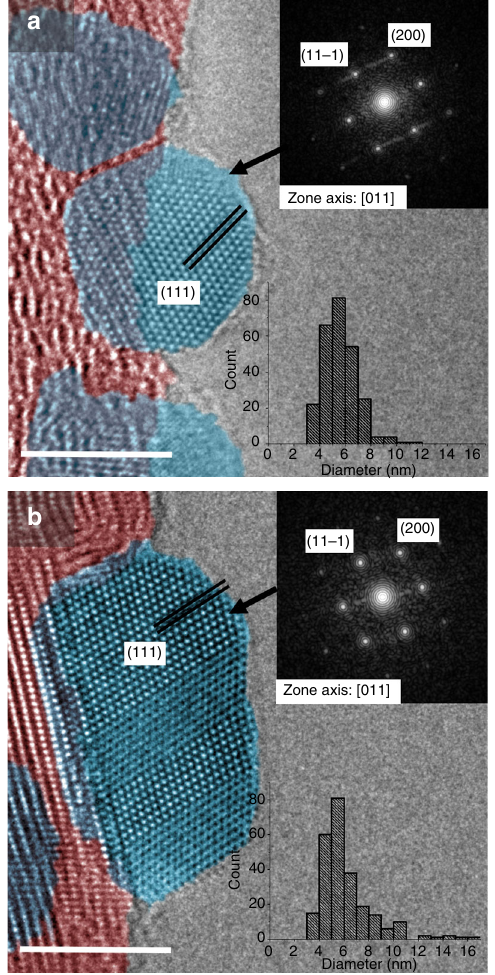
Fig. 5 Aberration-corrected TEM. The micrographs acquired for the a Pd/ PS and b Pd/HHT catalysts provide an atomic-resolution view of the Pd nanoparticles ( blue ) and of their interface with the carbon support ( red ). The insets show the fast Fourier transform results and the particle size distribution. The scale bars in the micrographs a , b represent 5